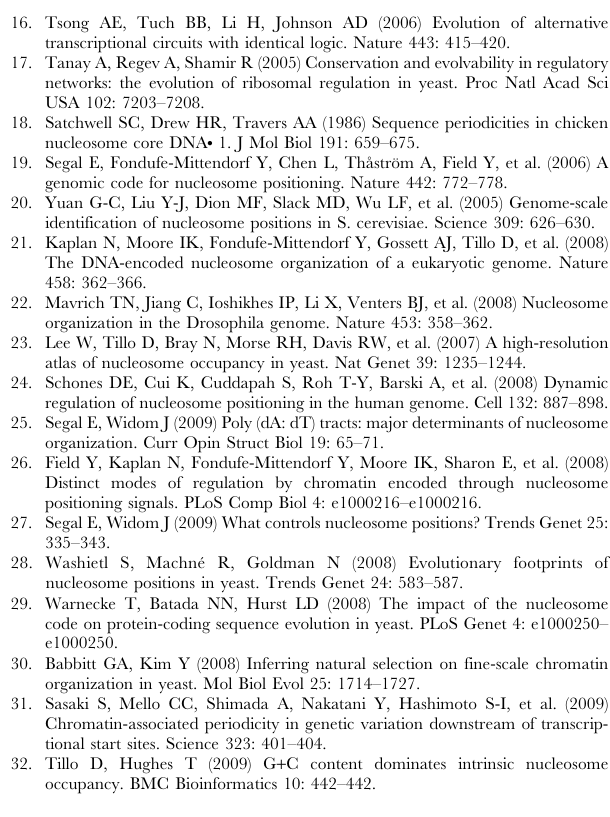
mutations (red) and A/T gaining mutations (blue) as approximated analytically (lines), compared to the empirical results (dots). Figure S9 Allele frequency of A/T gain and A/T loss SNP’s differences are robust to rare allele threshold. A–D) Minor allele frequency of non G/C contexts A/T loss, A/T gain and A/T neutral SNP’s across low and high occupancy loci. Shown are fraction of minor alleles at low occupancy loci with frequencies smaller than 0.14 (A), fraction of minor alleles at high occupancy loci with frequencies smaller than 0.14 (B), fraction of minor alleles at low occupancy loci with frequencies smaller than 0.3 (C), fraction of minor alleles at high occupancy loci with frequencies smaller than 0.3 (D). E–F) Cumulative distribution function of non G/C, minor allele frequency of A/T loss, A/T gain and A/T neutral SNP’s at low occupancy loci (E) and high occupancy loci (F). Figure S10 Parsimonious inference validates substitution rates heterogeneity and spatial coupling of A/T gain and loss events. A– B) Shown are A/T gain (blue) and A/T loss (red) substitution rates of the S. cerevisiae lineage inferred using parsimony (flanking context independent). Data is shown for TSS distal (A) and proximal (B) DNA sequences of S. cerevisiae, S. paradoxus and S. mikatae. A/T losing rate is , 50% decreased in low occupancy compared to high occupancy. C–D) Rates of A/T gain and loss events are spatially coupled. Shown is a comparison of the rate of A/T gaining substitution near parsimoniously inferred sites of AT losing (black) and AT gaining (red) substitution, plotted for different ranges of nucleosome occupancy (X axis) across TSS- distal (C) and TSS-proximal (D) loci. This analysis is consistent with the context dependent analysis. E-F) Similar analysis of A/T